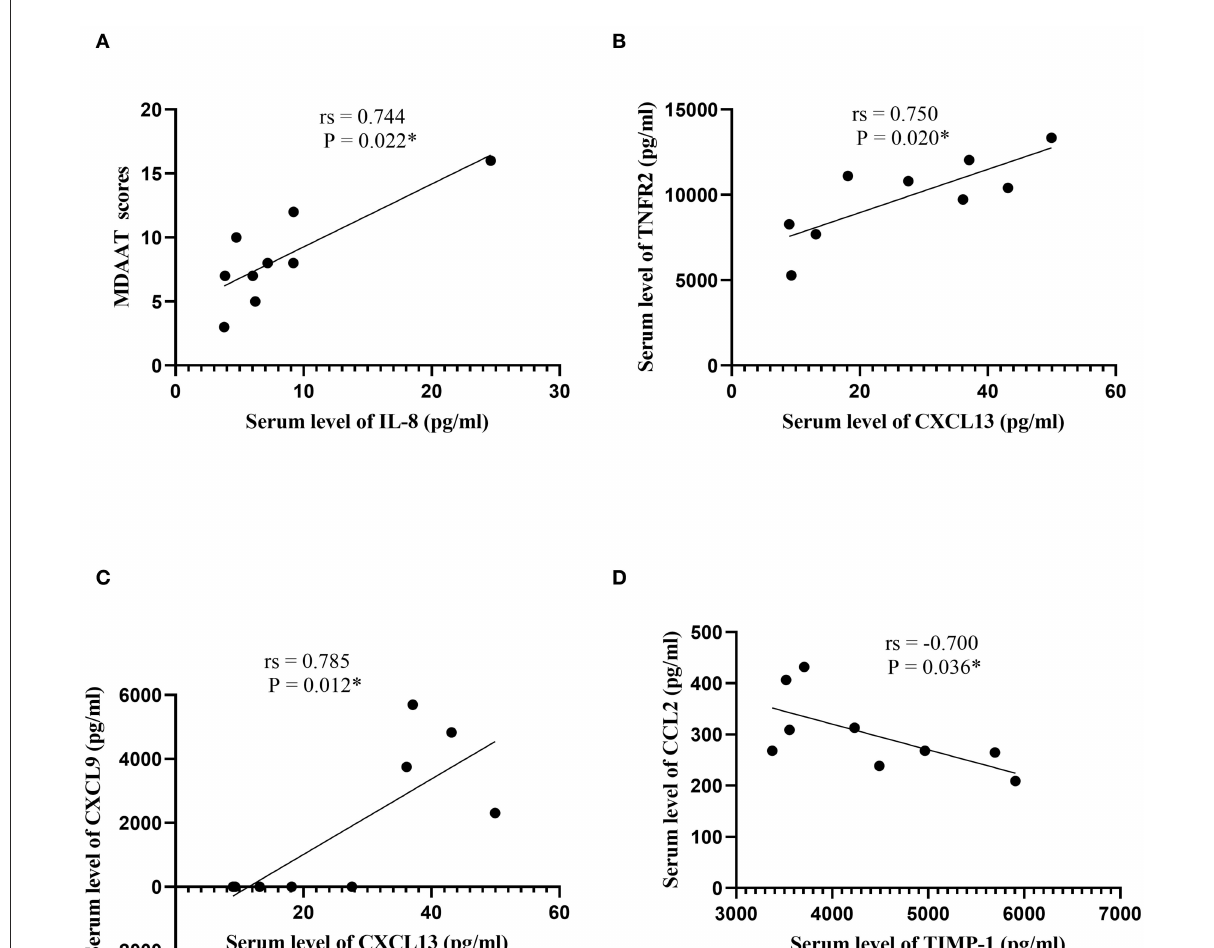
FIGURE4 Correlation analysis in patients with the anti-synthetase syndrome. (A) Correlation analysis between serum IL-8 levels and MDAAT scores. (B) Correlation analysis between serum CXCL13 levels and serum TNFR2 levels. (C) Correlation analysis between serum CXCL13 levels and serum CXCL9 levels. (D) Correlation analysis between serum TIMP-1 levels and serum CCL2 levels. IL, interleukin; MDAAT, Myositis Disease Activity Assessment Tool; CXCL, C-X-C motif chemokine ligand; TIMP-1, tissue inhibitor of metalloproteinases-1; CCL, C-C motif chemokine ligand. * P < 0.05.